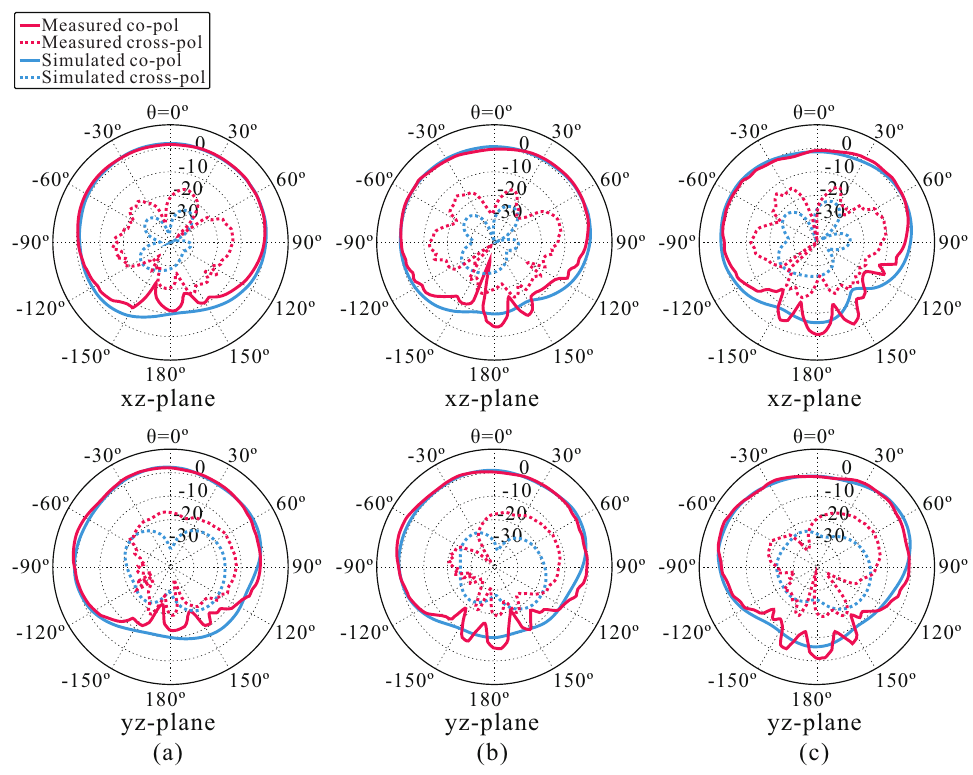
Figure 9. The far-field radiation pattern of the simulated and fabricated antennas: ( a ) 3.25, ( b ) 3.3, and ( c ) 3.35 GHz. Table 3. The measured boresight gain and 3-dB beamwidth of the proposed antenna.